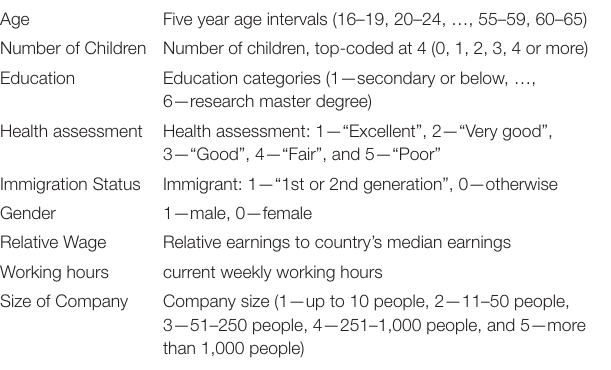
TABLE A1 | Control variable descriptions in PIAAC